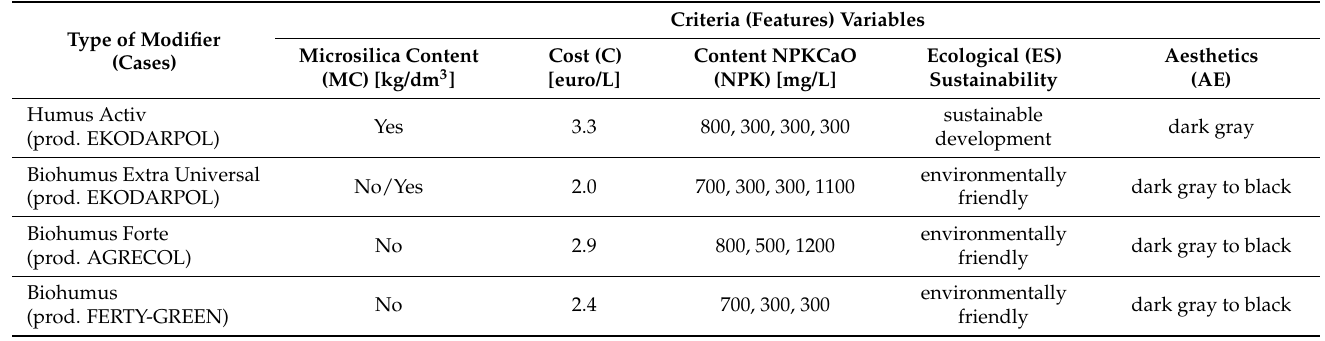
Table 1. Characteristics of organic silicate mass fillers for technical and economic analysis in measur- able and non-measurable